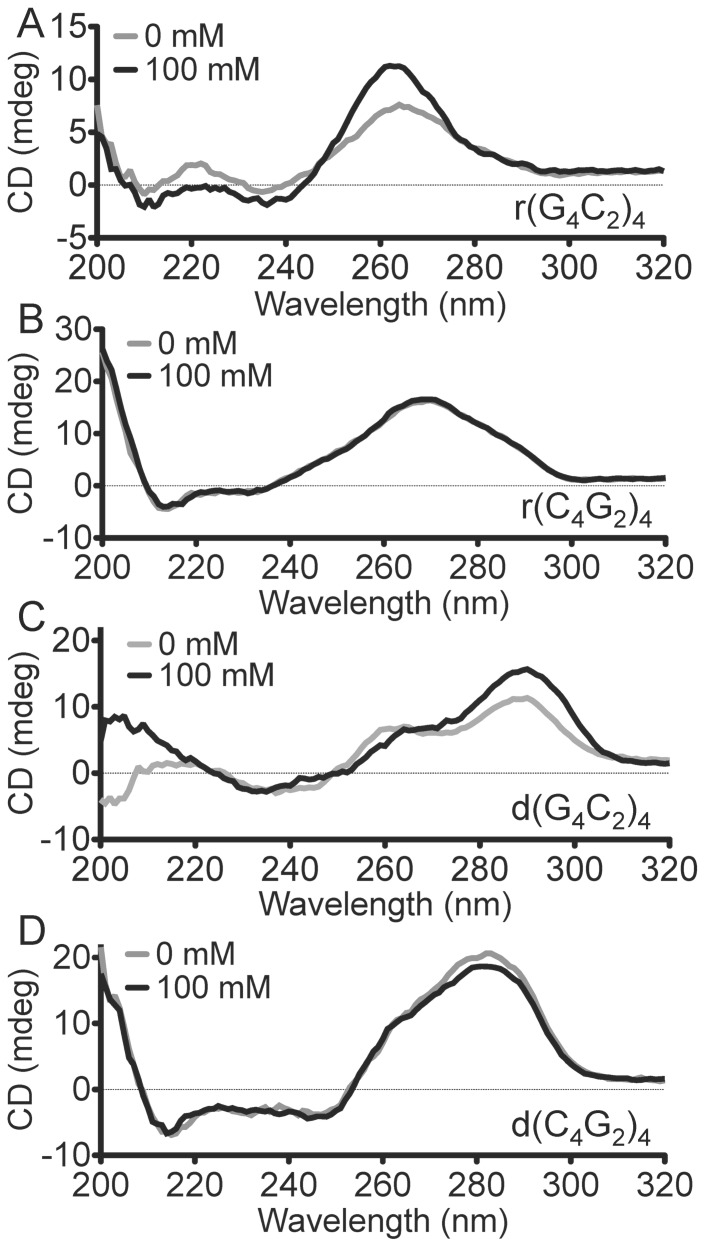
G-repeat expansion RNA and DNA form G-quadruplexes in the presence of potassium.UV Circular Dichroism spectra of (A) r(G4C2)4, (B) r(C4G2)4, (C) d(G4C2)4, and (D) d(C4G2)4 in 25 mM Tris, pH 7.5, in the presence of either 0 mM or 100 mM KCl.